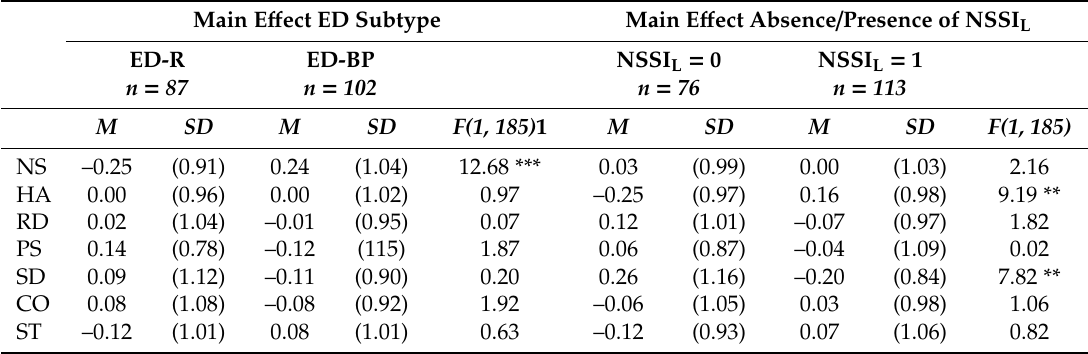
Table 5. Means and standard deviations of the z -scores of the brief Dutch version of Cloninger’s Temperament and Character Inventory for ED-R / BP patients with(out) lifetime